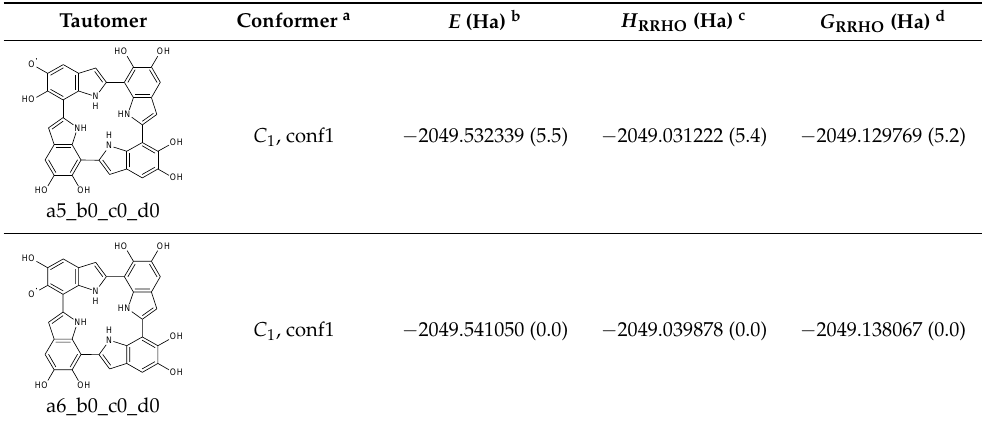
Table 4. KP-1e, neutral form in vacuo.